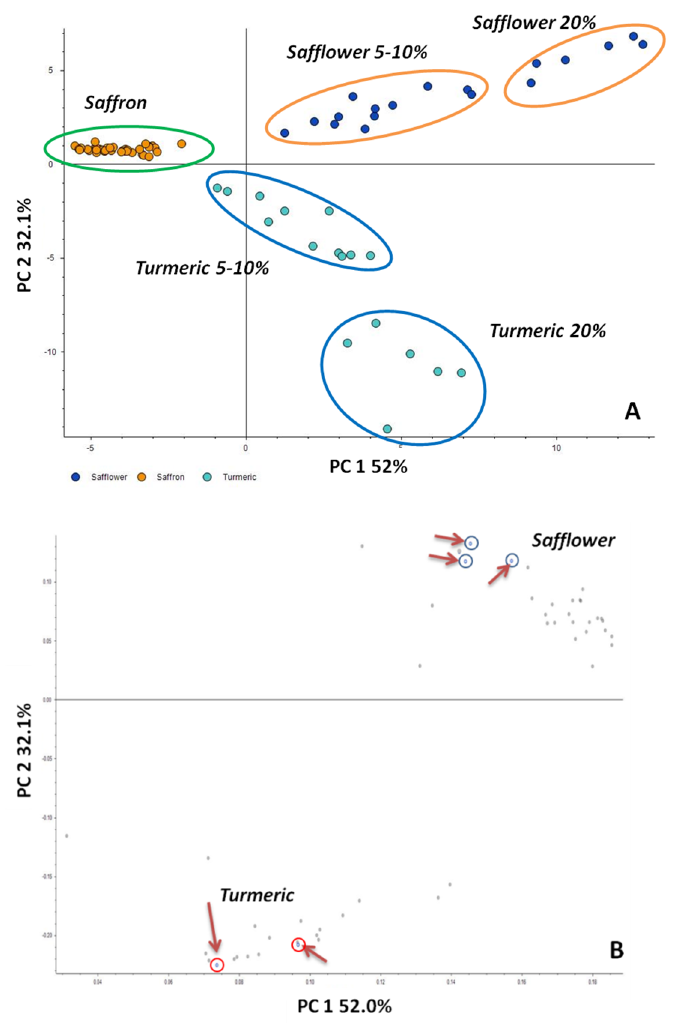
Figure 4. Principal component Analysis (PCA) scores plot ( A ) and loading plot ( B ) obtained for positive ionization mode after data filtration by a p -value threshold (≤0.05). Data points which strongly contribute to both principal components are target with arrows in the loading plot.